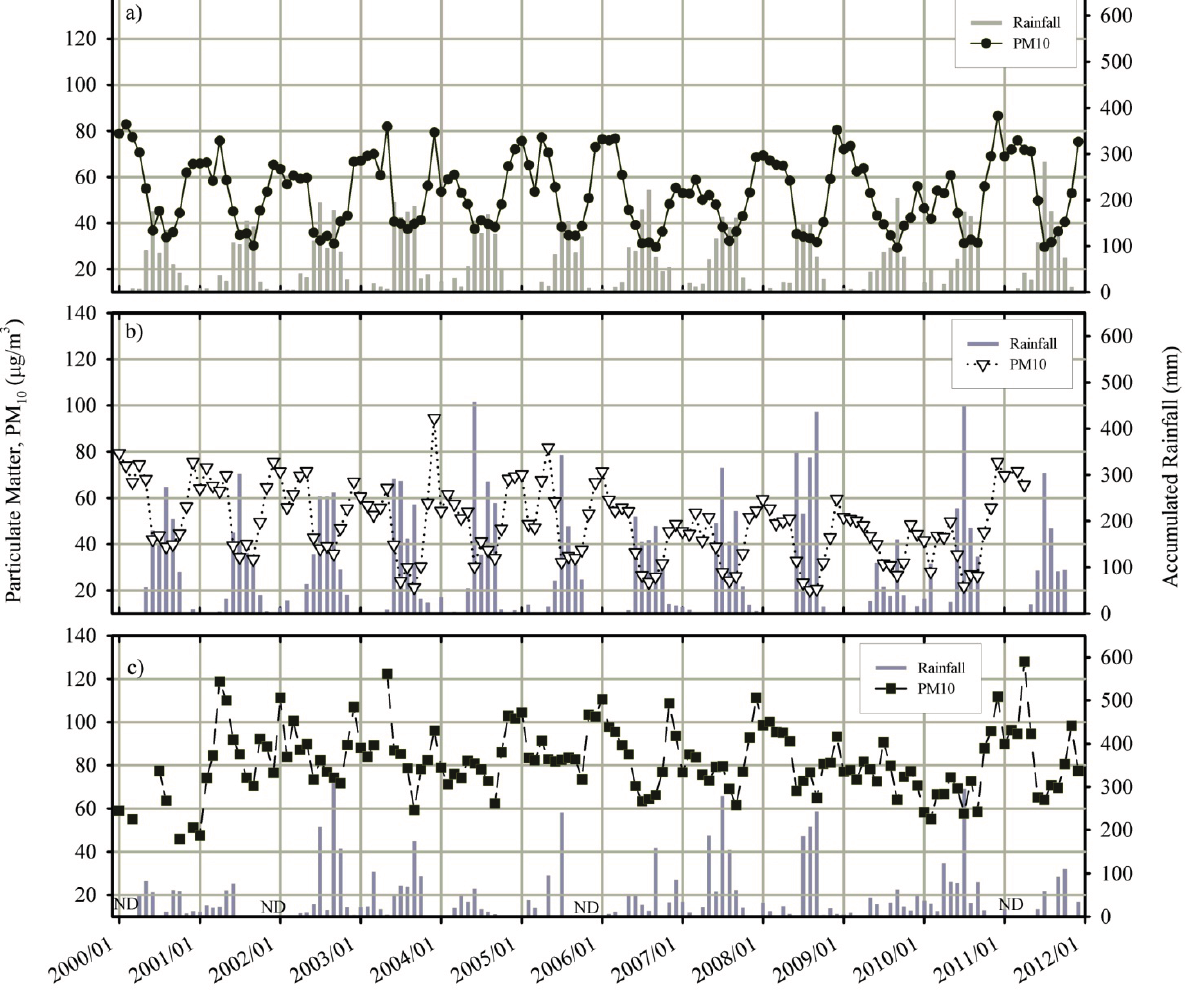
concentration and 10